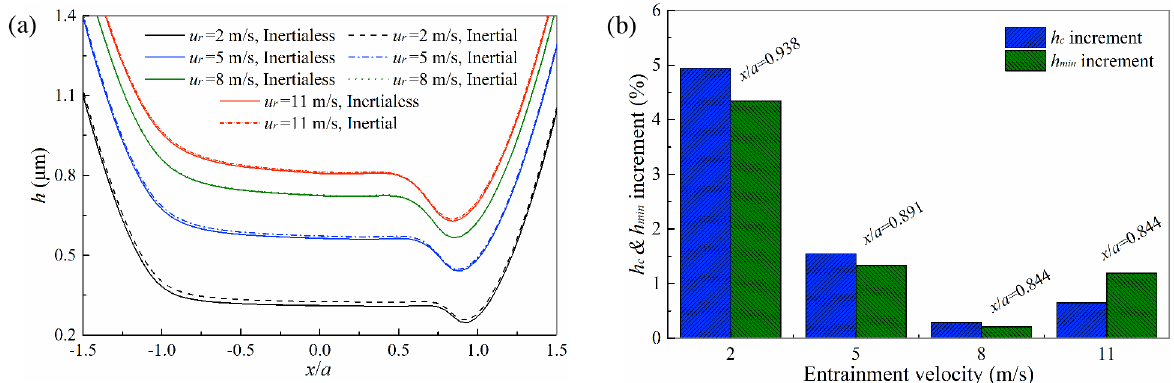
Fig. 10. Effects of inertia on fi lm thickness at varied entrainment velocity ( y = 0): (a) fi lm thickness, and (b) maximum relative percentage of fi lm thickness.